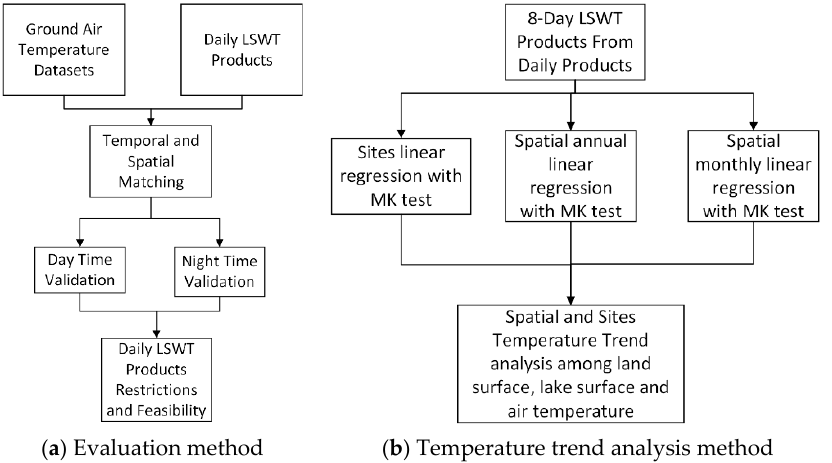
Figure 2. The scheme in this study. (a) Evaluation method; (b) Temperature trend analysis method.